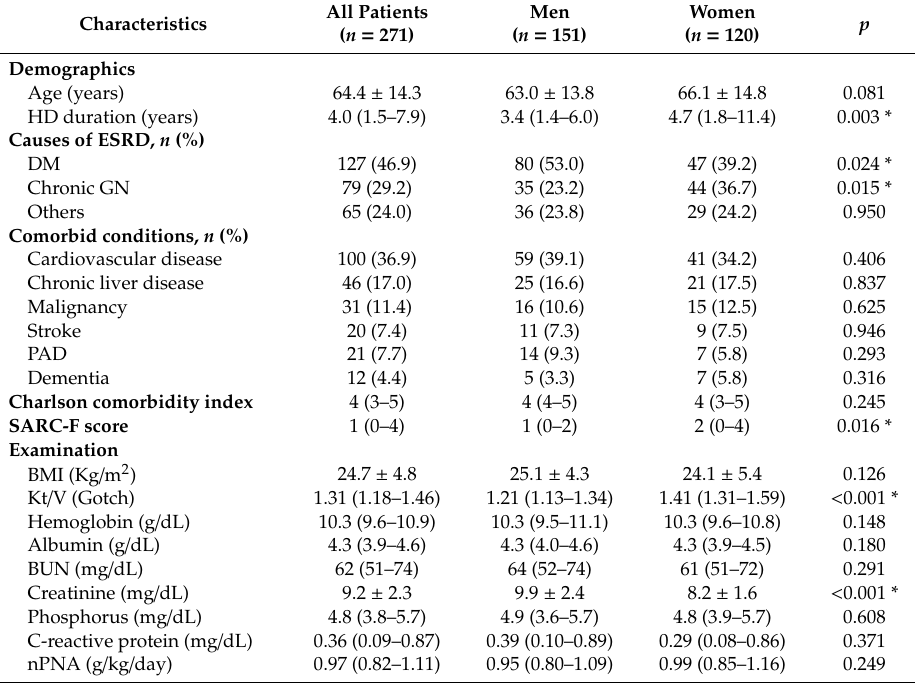
Table 1. Clinical characteristics of the 271 hemodialysis patients and comparison between males and females.